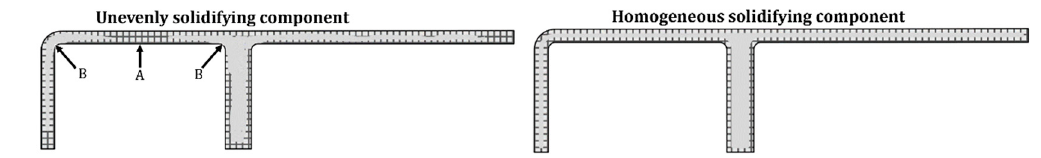
Figure 14. Schematic representation of the semi-solidified component, once unevenly solidifying ( left ) and once homoge- neously solidifying ( right ).